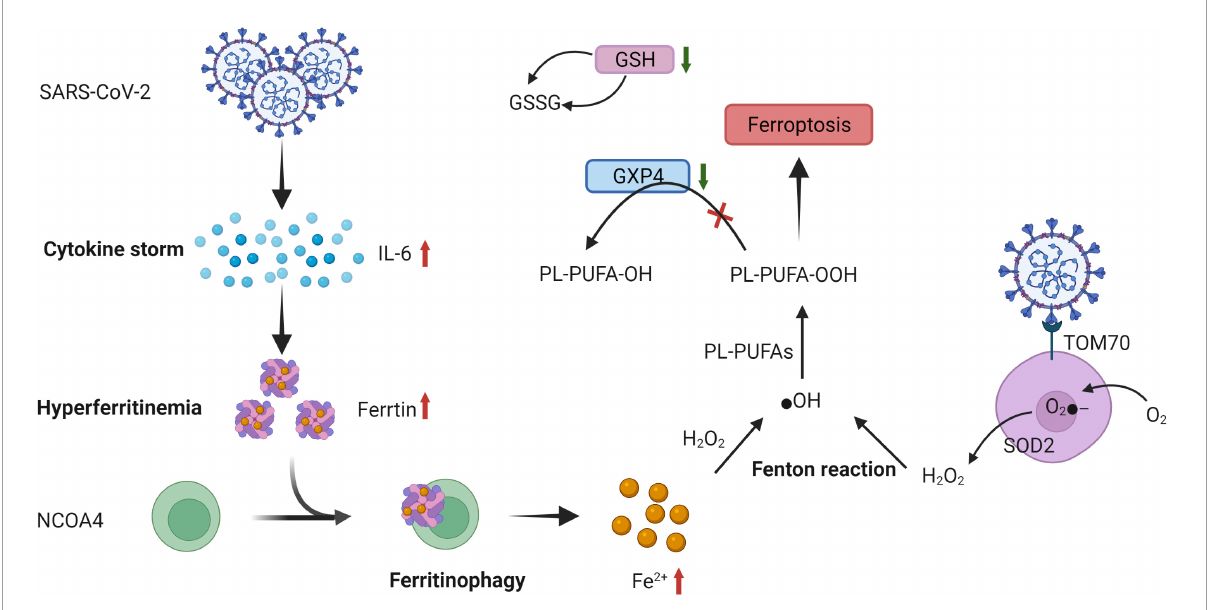
FIGURE4 Proposed mechanism of ferroptosis in SARS-CoV-2 infection. SARS-CoV-2-related increase in cytokines, especially IL-6 causing hyperferritinemia, is characterized by the increase in intracellular iron and ferritin. This increased ferritin binds to NCOA4 and is delivered to autophagosomes, causing ferritinophagy and triggering an increase in the labile iron pool, which induces OH through the Fenton reaction and, eventually, through PL-PUFA peroxidation, which promotes ferroptosis. The expression of GSH and ferroptosis-associated GPX4 is suppressed by severe acute respiratory syndrome coronavirus 2 (SARS-CoV-2) infection. Moreover, a low GSH pool and downregulation of GPX4 gene expression caused by SARS-CoV-2 infection facilitate ferroptosis. Orf9b, one of the accessory proteins of SARS-CoV-2, increases ROS generation by binding to TOM70 at the surface of the mitochondria membrane. O 2 - is produced by ETC on the internal membrane of the mitochondria and then converted to further H 2 O 2 by SOD and eventually, by Fenton reaction, transformed into · OH, triggering LOOH generation from PUFAs that promotes ferroptosis. SARS-CoV-2, severe acute respiratory syndrome coronavirus 2; IL-6, interleukin-6; NCOA4, nuclear receptor coactivator 4; · OH, hydroxyl radical; PL-PUFAs, phospholipid polyunsaturated fatty acids; PUFA-OH, phospholipid polyunsaturated fatty acid alcohols; PL-PUFA-OOH, phospholipid polyunsaturated fatty acid peroxides; GSH, glutathione; GSSG, oxidized glutathione; GPX4, glutathione peroxidase; Orf9B, open reading frame-9b; ROS, reactive oxygen species; TOM70, translocase of outer membrane 70; O 2 -, superoxide; ETC, electron transport chain; H 2 O 2 , hydrogen peroxide; SOD, superoxide dismutase; LOOH,